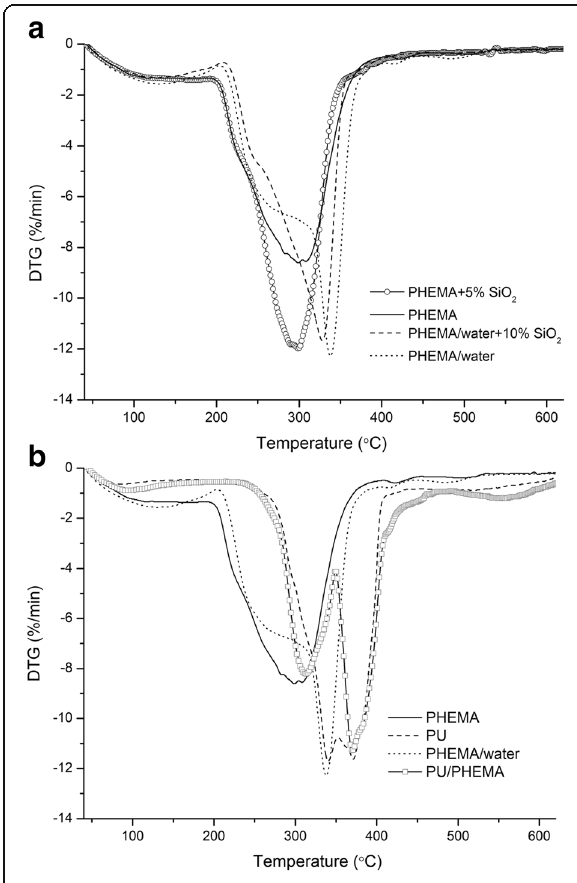
Fig. 7 DTG curves of samples based on various polymer matrices with a filler ( a ) and without it ( b )